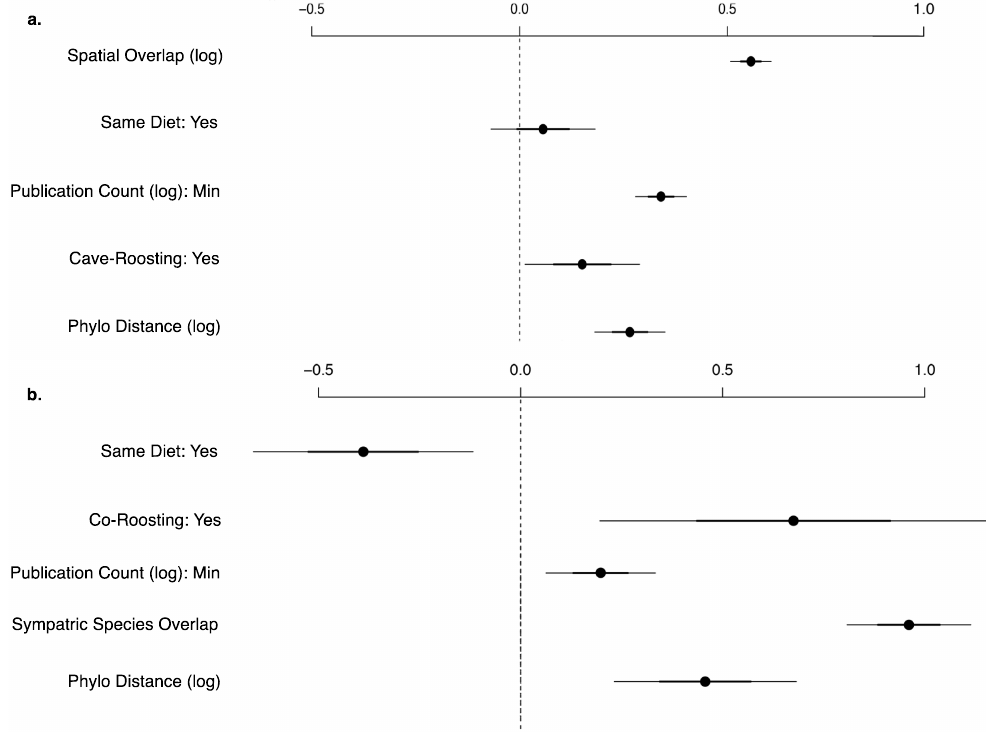
Figure 4. Coefficient plot for the best viral sharing generalized linear models for shared stringent viruses (Y/N) between ( a ) all bat species-pairs ( n = 7864) and ( b ) co-roosting bat species-pairs ( n = 1378). Each model includes publication count, phylogenetic distance, shared roosting behavior, and shared dietary niche. Spatial overlap is the best predictor for all species, while number of sympatric viral hosts performed better in the co-roosting species subset. All variables are